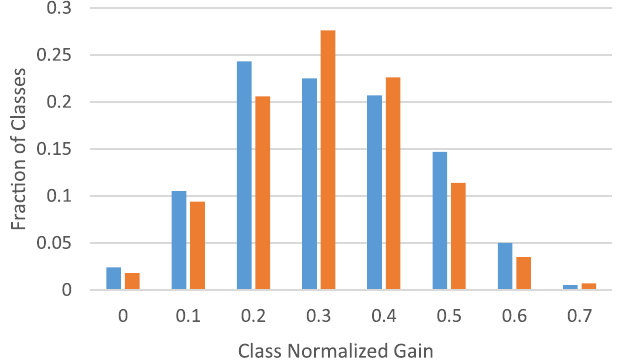
FIG. 2. Comparison of distribution of class normalized gains for 382 IE classes from Physport (blue) with a normal distribution (red) having the same mean (0.30) and standard deviation (0.14).